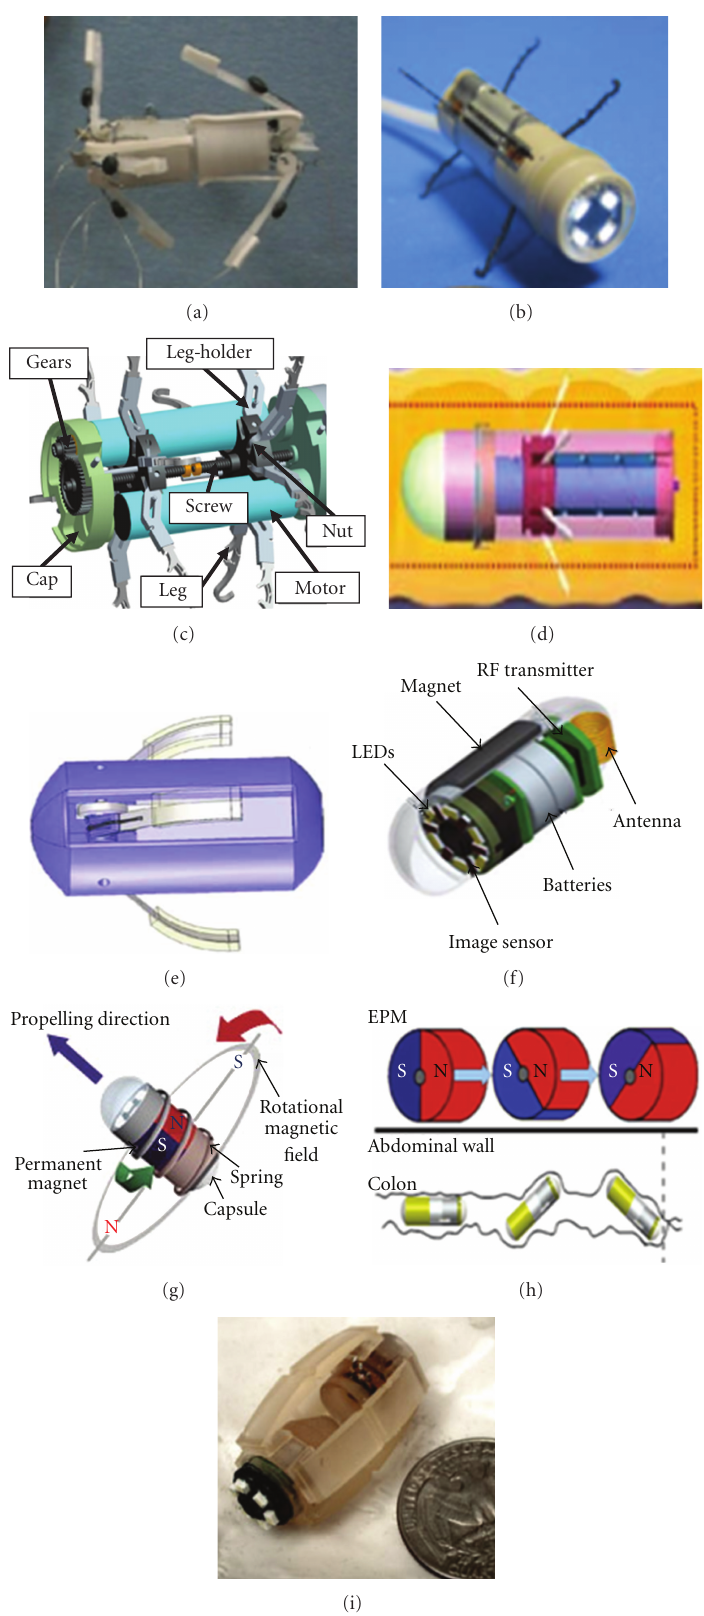
Figure 7: Capsule actuation mechanisms proposed by (a) Karagozler et al. [65], (b) Quirini et al. [66], (c) Quaglia et al. [67], (d) Yang et al. [68] (e) Glass et al. [69], (f) Gao et al. [71], (g) Olympus, Inc. [70], (h) Simi et al. [72], and (i) Yim and Sitti